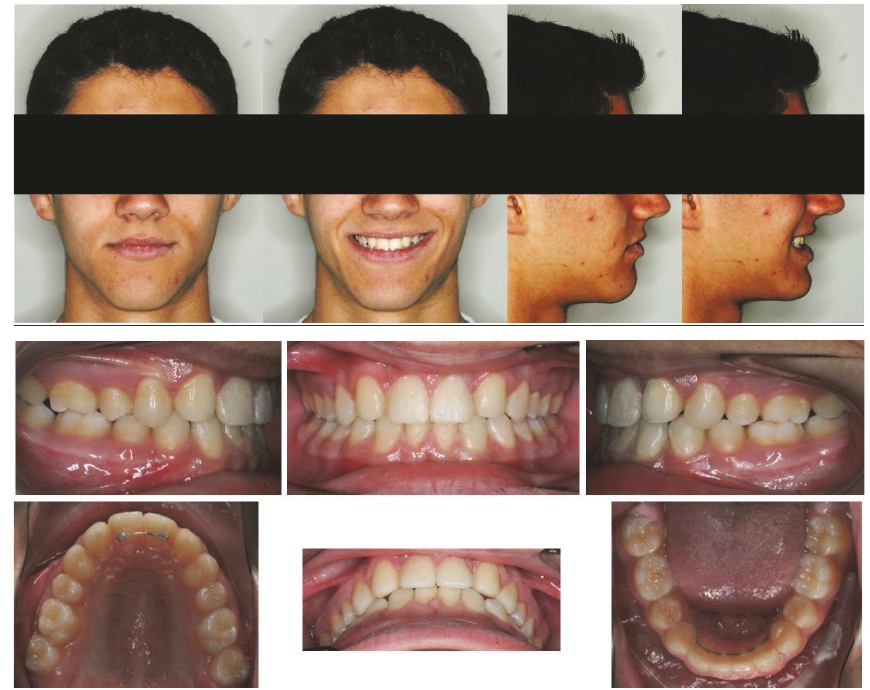
Figure 4: Final diagnostic